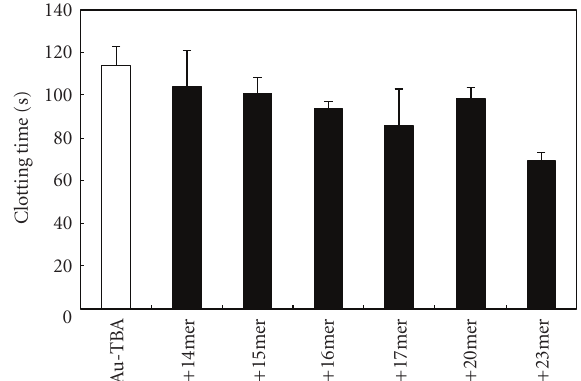
Figure 2: Evaluation of the e ff ect of RFMF on thrombin activity. Mixtures of Au-TBA and thrombin were irradiated for 5min, 15min, or 30min. As control, the mixtures were incubated for the same time at room temperature. Fibrinogen was added, and then, the clotting time was measured. White bars show clotting times without RFMF irradiation. Black bars show clotting times with RFMF irradiation.